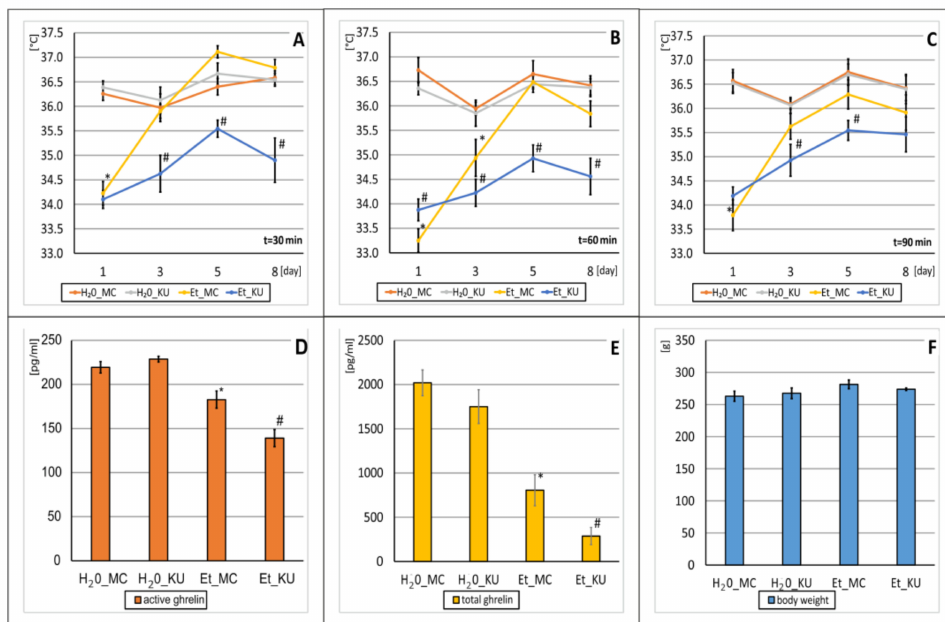
Figure 8. The effect of repeated once a day for 9 days (9 × ) Pueraria lobata root extract (KU) (500 mg/kg, p.o.) administration on ethanol (3.0 g/kg/day, i.p.) tolerance development, ghre- lin levels, and body weight in alcohol Warsaw High-Preferring (WHP) rats. Legend: n = 6–8; mean ± SEM; MC—0.5% methylcellulose; Et—30% ethanol; H 2 O_MC—absolute control